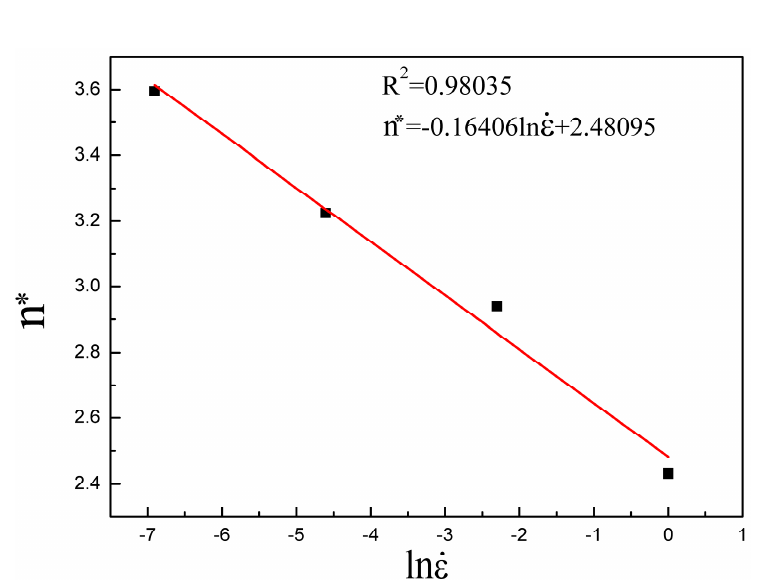
. ε . The linear curve is obtained from linear ε  ∗ n and . The linear curve is obtained from linear fitting.